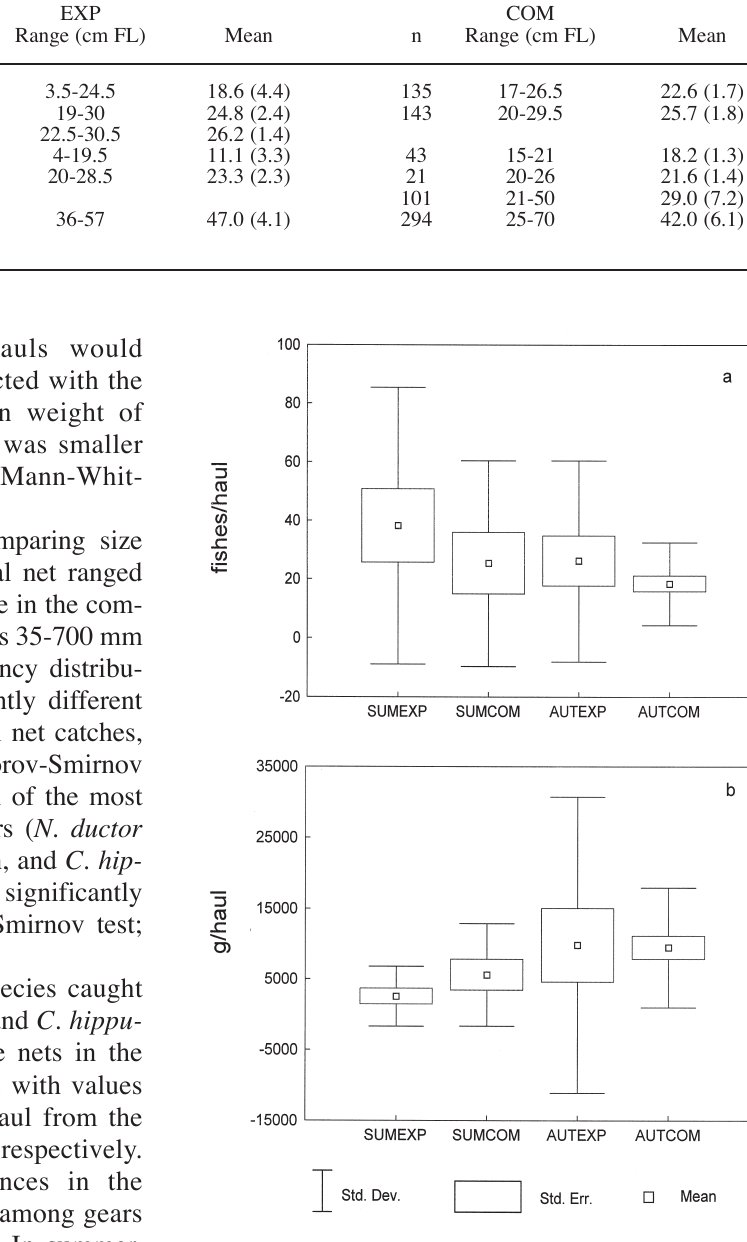
SAMPLING FISH ASSOCIATED WITH FLOATING OBJECTS